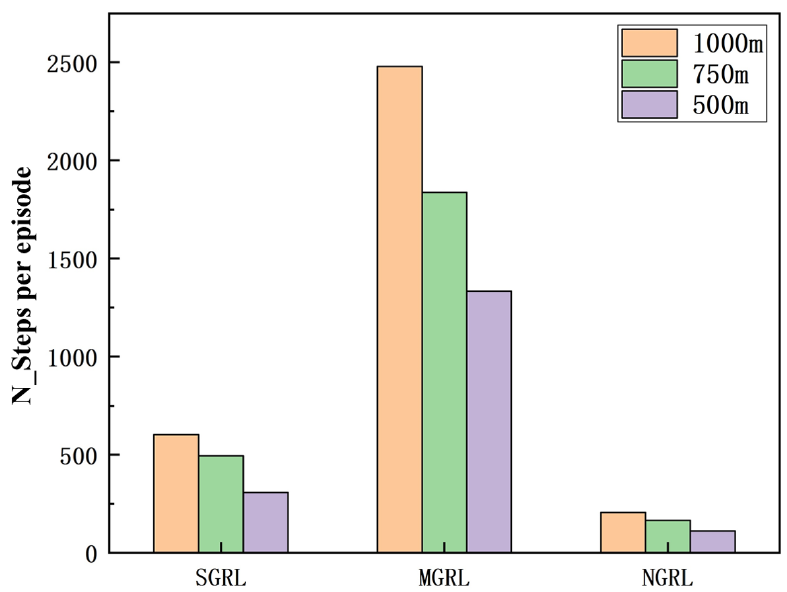
Figure 21. Diagram of testing average steps. This value is the number of steps experienced at the end of each episode.